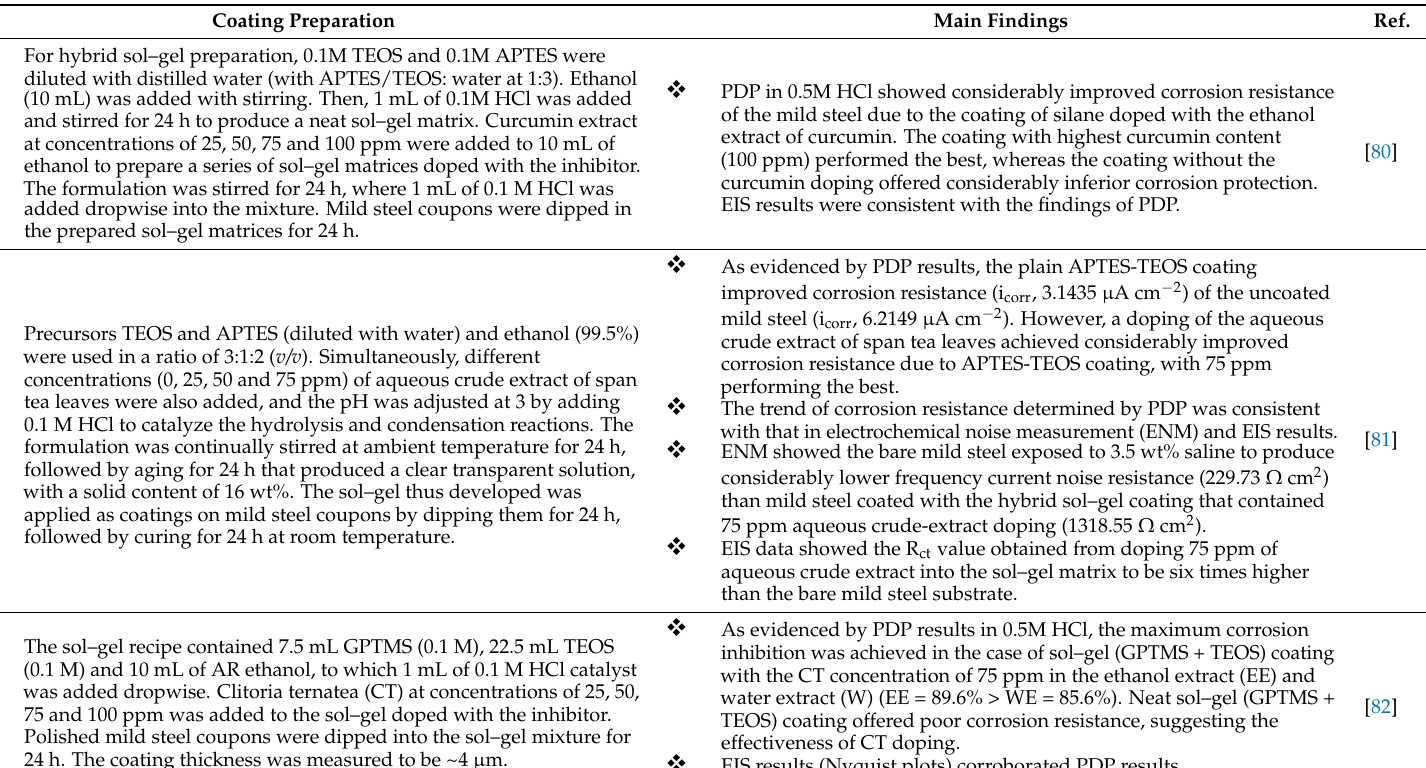
Table 1. Different approaches for improving silane coatings and the main findings, as reported in the